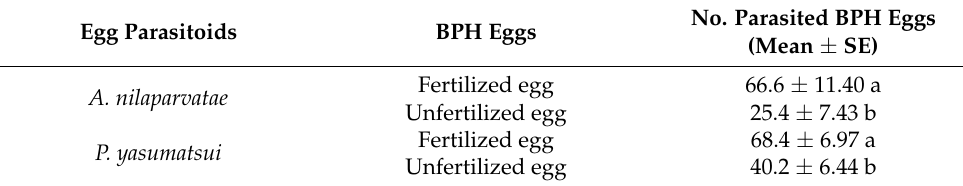
Table 2. Parasitism preference of the two egg parasitoids between fertilized and unfertilized BPH